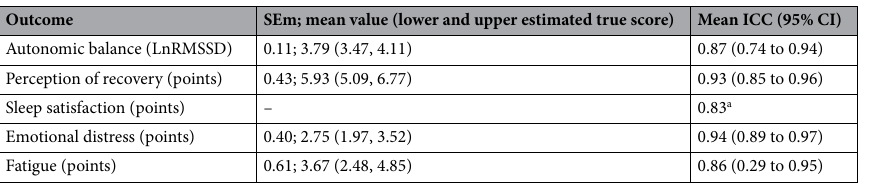
Table 2. Indices of reliability of ATOPE+mHealth system for mean HRV parameter, recovery, sleep, emotional distress and fatigue of breast cancer survivors (N = 21). ICC intraclass correlation coefficient (95% confidence interval); LnRMSSD natural logarithm of the mean square root differences of the standard deviation; SEm standard error of measurement. a Weighted kappa.